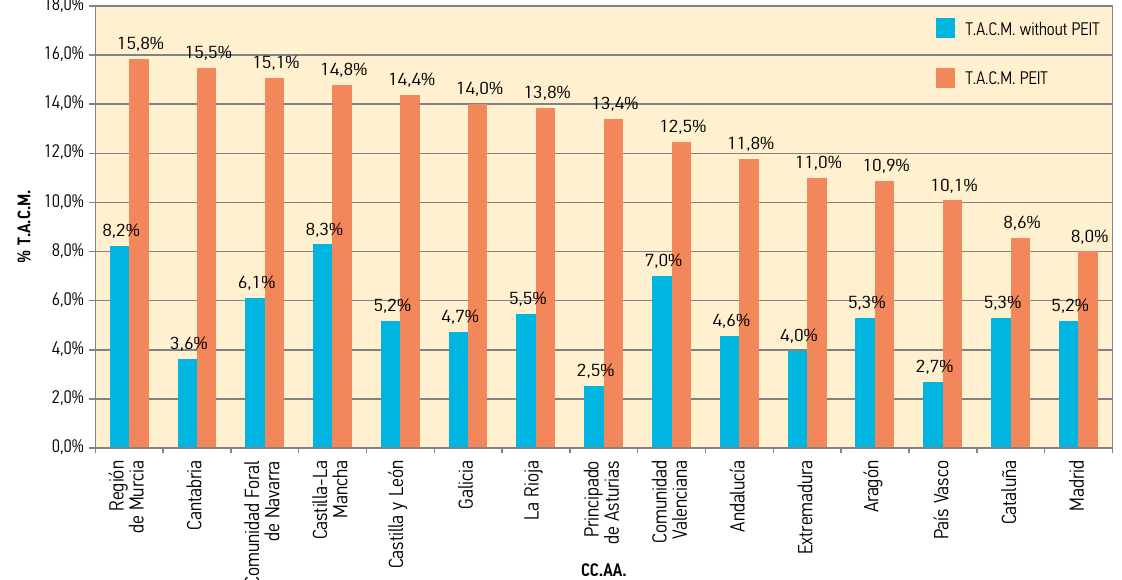
Fig. 5. Comparison of average annual accumulative GOS rates at constant prices (notes: base 2005 = 100; period – 2005–2020)